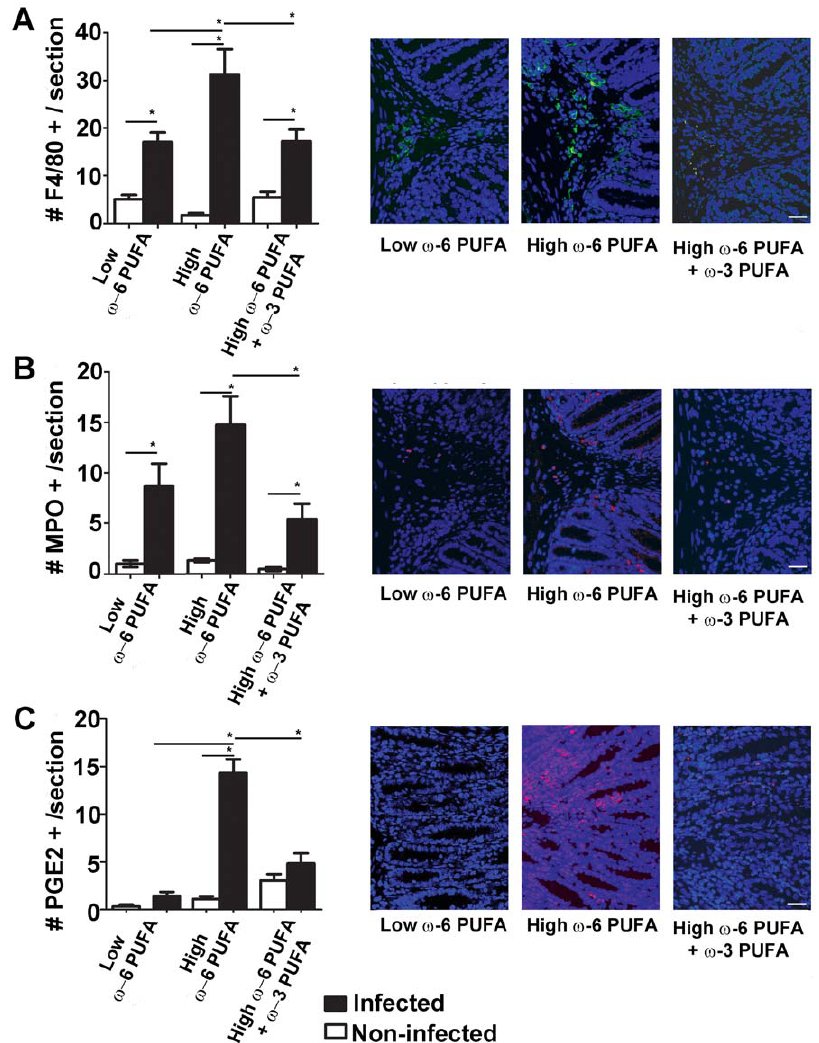
Figure 3. v -3 PUFA supplementation to v -6 PUFA rich diets impairs intestinal inflammatory cell infiltration during C.rodentium- induced colitis. While v -6 PUFA rich diets induced the infiltration of macrophages, neutrophils and PGE2 inflammatory cells, v -3 PUFA supplementation prevented the enhanced infiltration during infection. Colon sections were stained for the presence of submucosal A) F4/80 + macrophages B) MPO + neutrophils and C) PGE2 + cells and quantified. Representative immunofluorescence images are shown at 200 6 magnification. (scale bar=13.6 m m; *, P , 0.05).